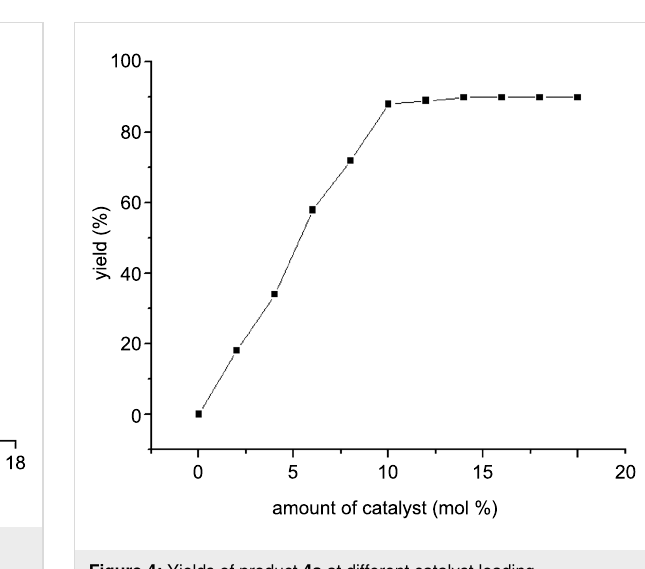
Substrate scope